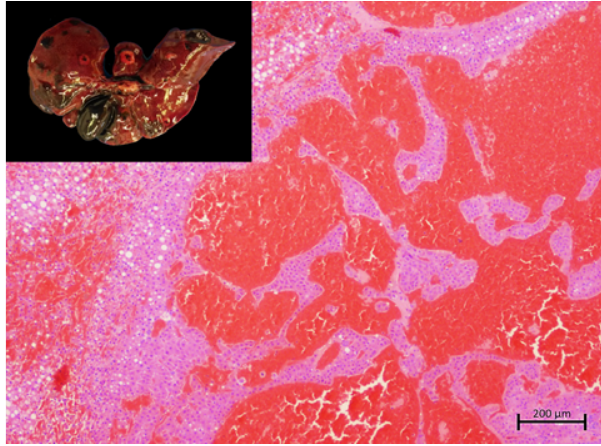
Figure 2: Hepatic peliosis. Hepatic peliosis characterised by large blood-filled spaces bordered by compressed hepatocytes (HE stain, bar = 200 µ m). Inset: Macroscopic image showing multifocal, irregular to round, well-demarcated, blood-filled, proliferative lesions in the liver.